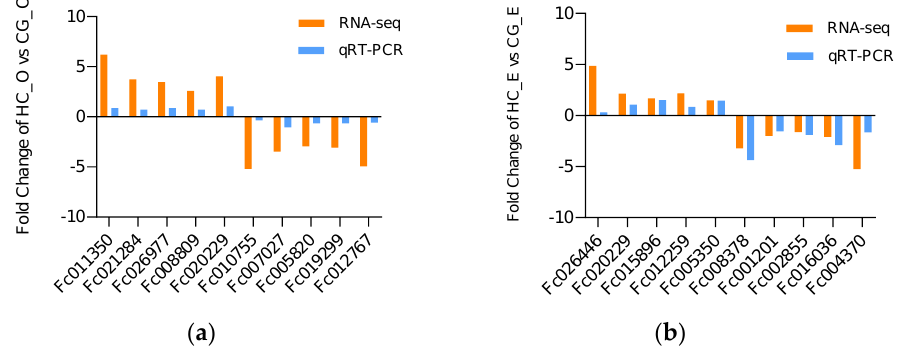
Figure 6. The heatmap of DEGs related to ovarian development in the HC_E vs. CG_E group.